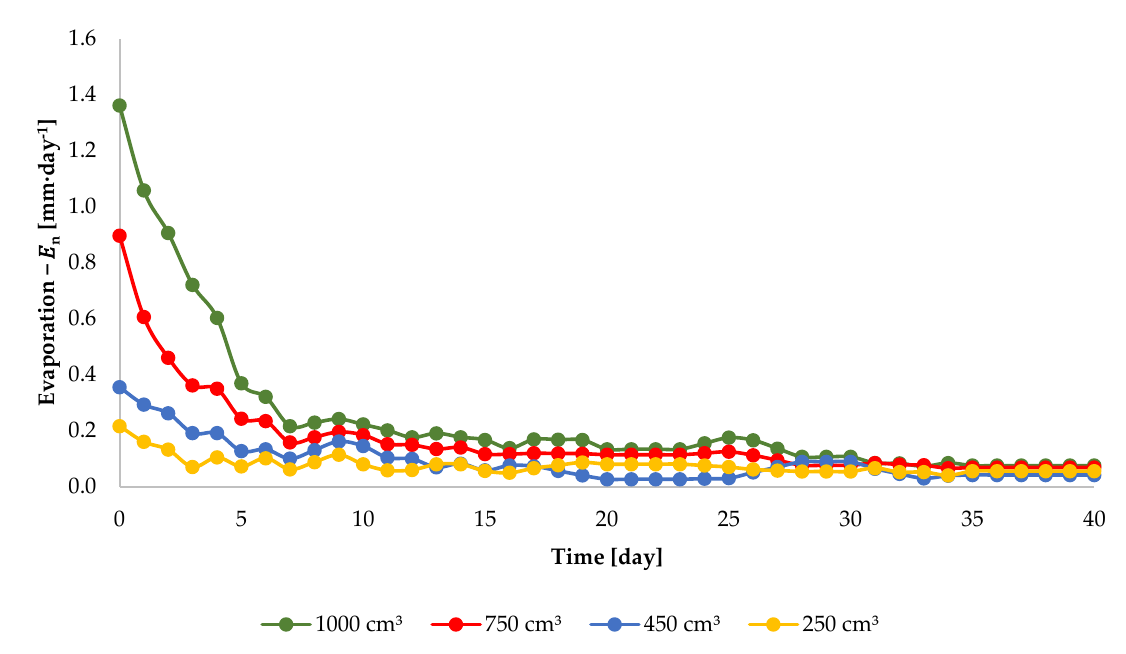
lower the value of . For instance, on day 5 of the experiment, for an injection depth of